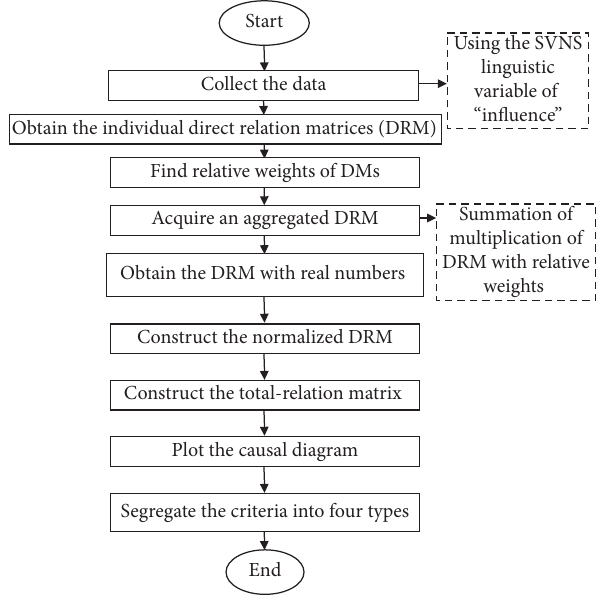
Figure 1: Framework of the proposed